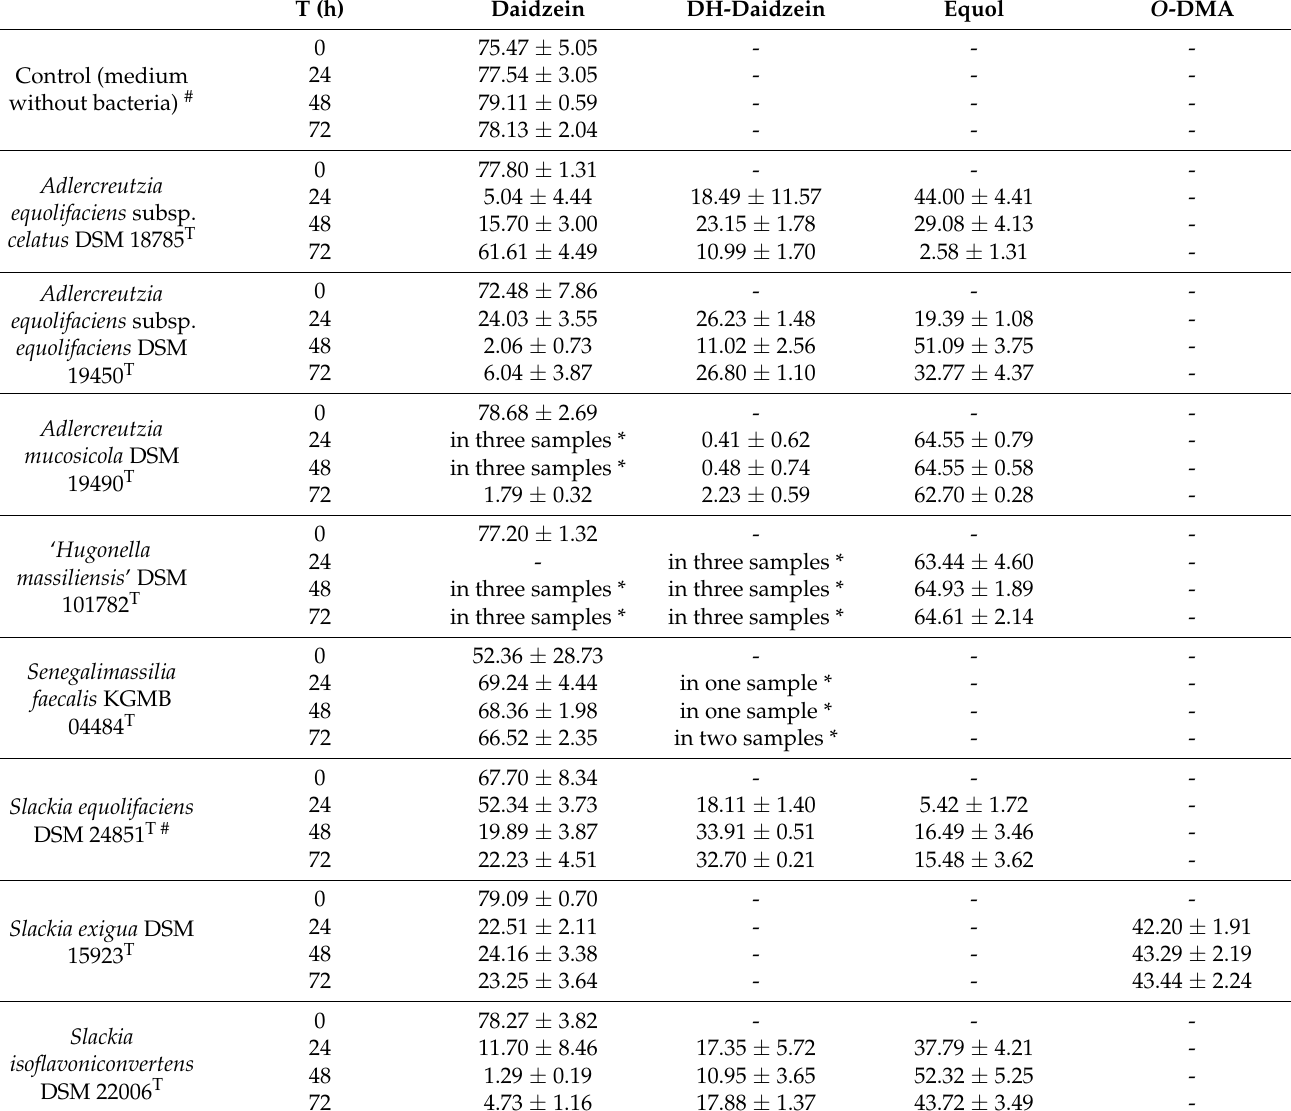
Table 1. Concentrations [ µ M] of daidzein and its metabolites measured by LC-DAD in fermentation samples inoculated with pure cultures of Eggerthellaceae and Coriobacteriaceae strains. The initial concentration of daidzein was 78.4 µ M. Results are the mean values ± standard deviations of triplicates and for their calculation, values between limit of detection (LOD) and limit of quantitation (LOQ) were set as LOD, and values <LOD were set as zero. DH-Daidzein, Dihydrodaidzein; O -DMA, O -Desmethylangolensin; SD, standard deviation; -, not detected or values below